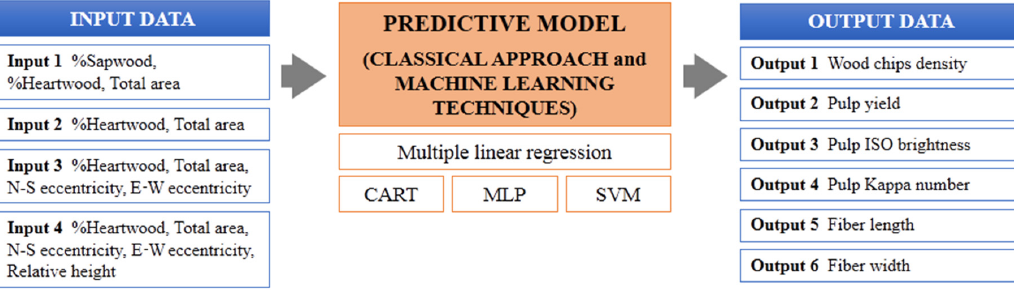
Figure 1. Predictive model defined in this paper. CART, Classification and Regression Trees; MLP, Multi-Layer Perceptron; SVM, Support Vector Machines; N, North; S, South; E, East; W,